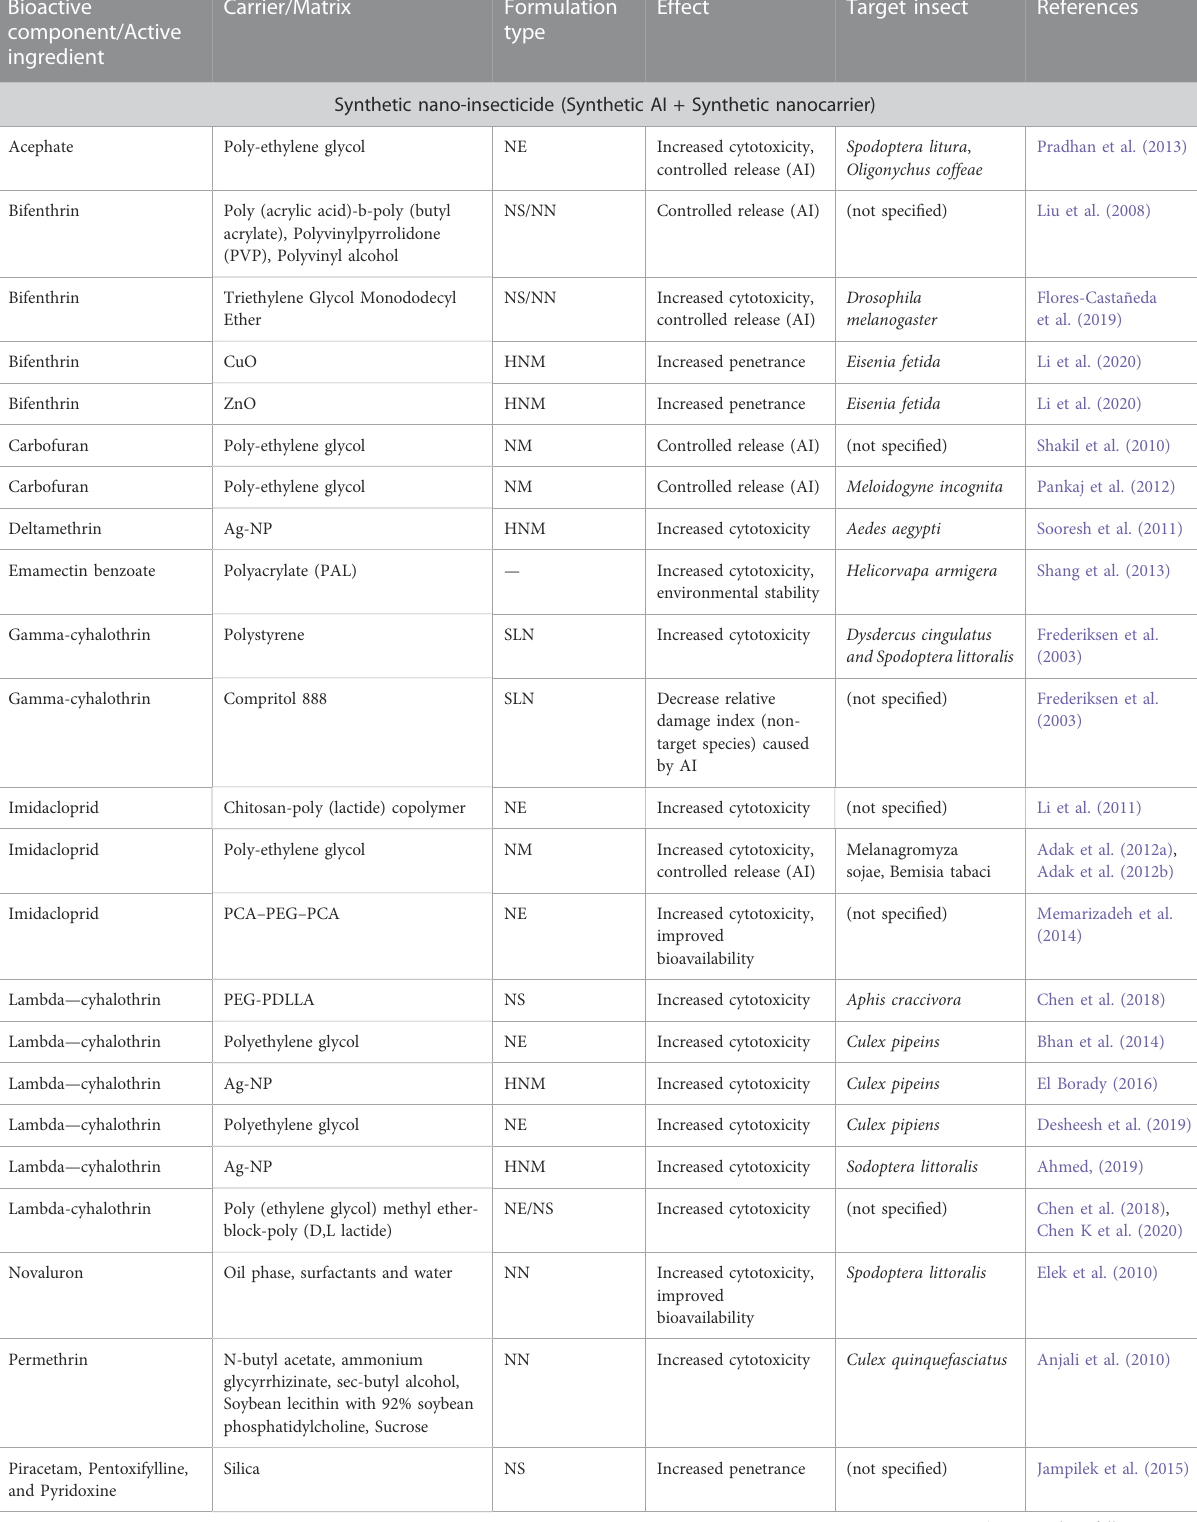
TABLE 1 List of experimentally successful nanoinsecticide formulations (active ingredients and carriers) and their functional superiority to conventional chemical insecticides (Abbreviations; HNM, Hybrid nano metal; NE, Nano encapsulation; NG, Nano gel; NM, Nano micelle; NN, Nano emulsion; NS,